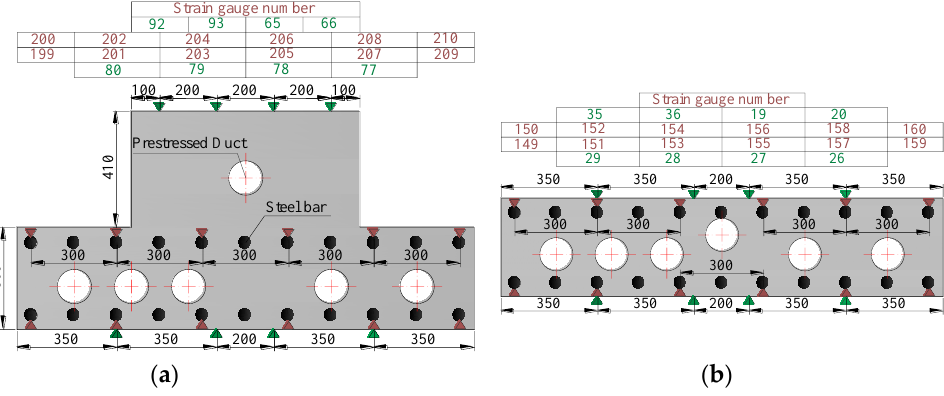
Figure 10. The arrangement of the strain gauges on the bottom slab specimen (unit: mm): ( a ) Section